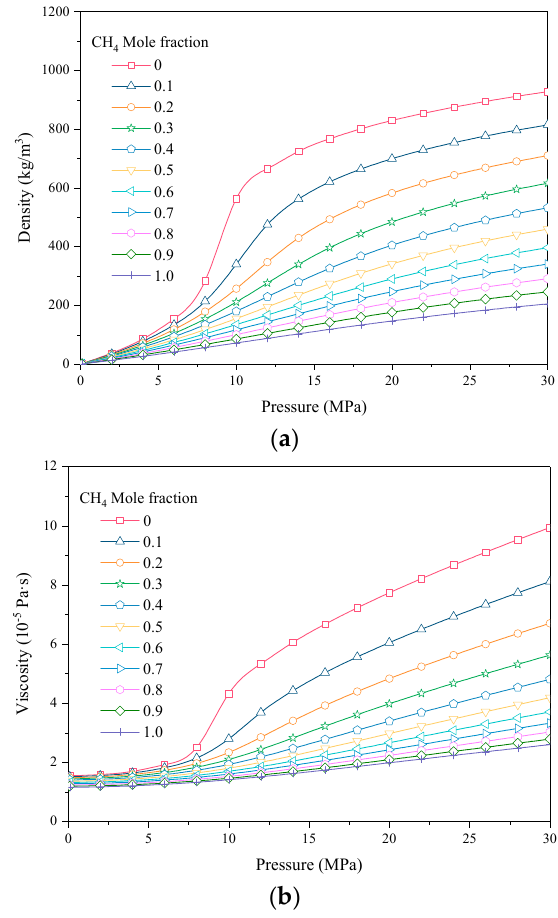
Figure 4. ( a ) Density of CO 2 –CH 4 mixtures at 40 °C and ( b ) viscosity of CO 2 –CH 4 mixtures at 40 °C.